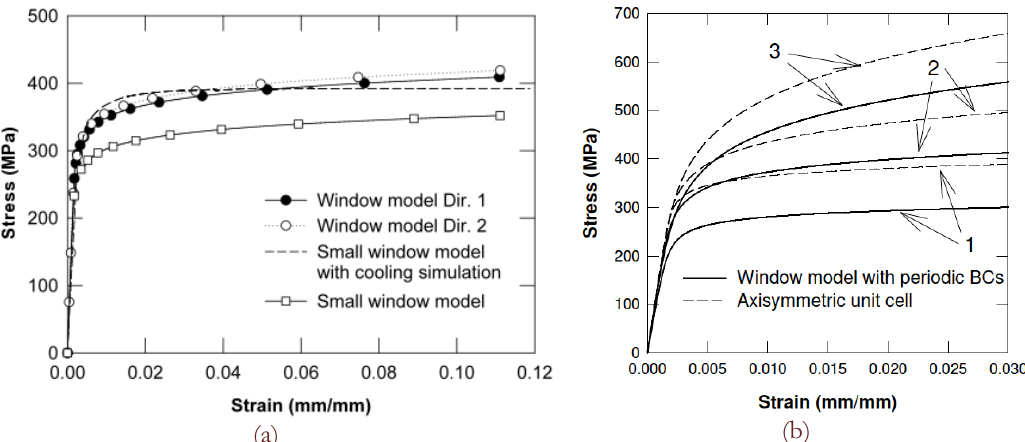
Figura 13: Risposte meccaniche della ghisa nodulare simulate con modelli discreti della microstruttura: (a) curve di trazione dei modelli di Fig. 12; (b) risposte meccaniche dei modelli a condizioni al contorno periodiche di Fig. 14 (1 = 100% Fe; 2 = 68% Fe; 3 = 19% Fe)